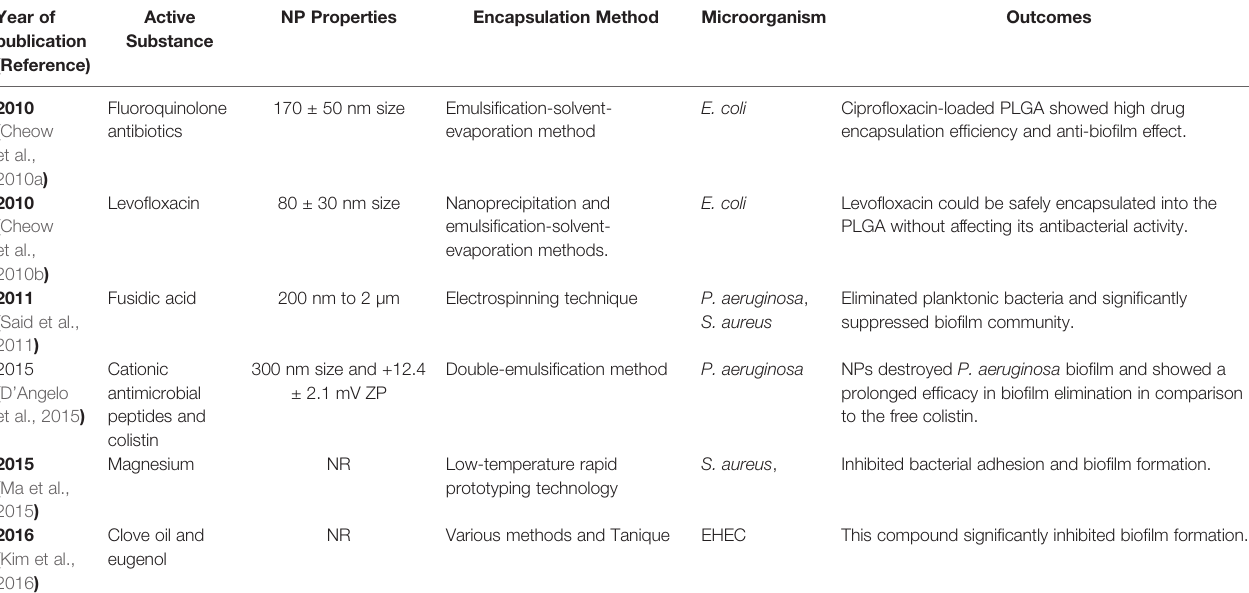
TABLE 1 | Previous studies that used PLGA NPFs for inhibition of the microbial bio fi lm. PLGA: poly (lactide